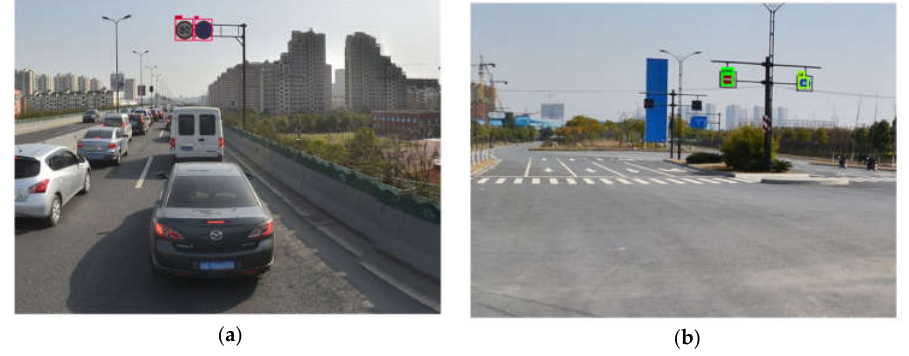
Figure 18. Detection examples. ( a ) site 1; ( b ) site 2.